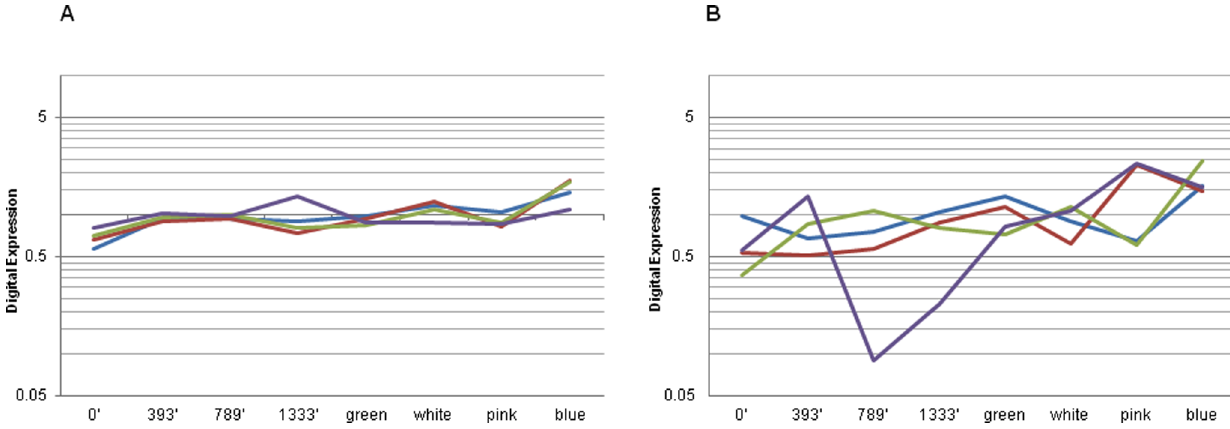
Figure 1. Digital expression level of blueberry genes in dormant floral buds and fruits at different stages of development. A. Relative virtual expression of unigenes from the 454 transcriptome database representing putative orthologs to Arabidopsis genes UBC9 (contig02681 and contig14017 with 96% and 93% identity at the amino acid level, respectively; red and blue), UBC28 (contig13874 with 92% identity; green) and RH8 (contig01609 with 45% identity; purple). B. Relative virtual expression of former frequently used blueberry reference genes in qPCR analyses, i.e. ACT (contig00039, red), metallothionein (contig0266, purple), GAPDH (contig00502, blue) and EF1a (contig14280, green). Contig Ids are from the ‘All’ assembly from the transcriptome database [22]. The digital expression for each contig in every sample is expressed relative to the average expression level over all the libraries.